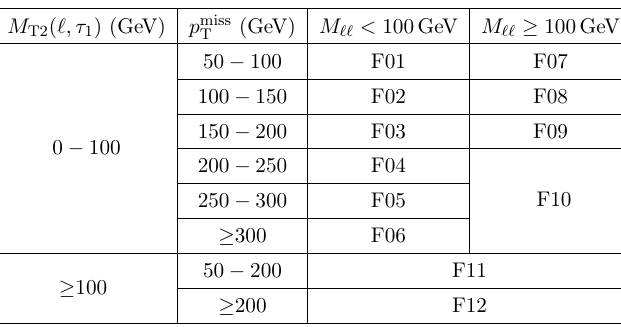
Table 7 . Search region de(cid:12)nition corresponding to category F, events with one electron or muon and two (cid:28) h